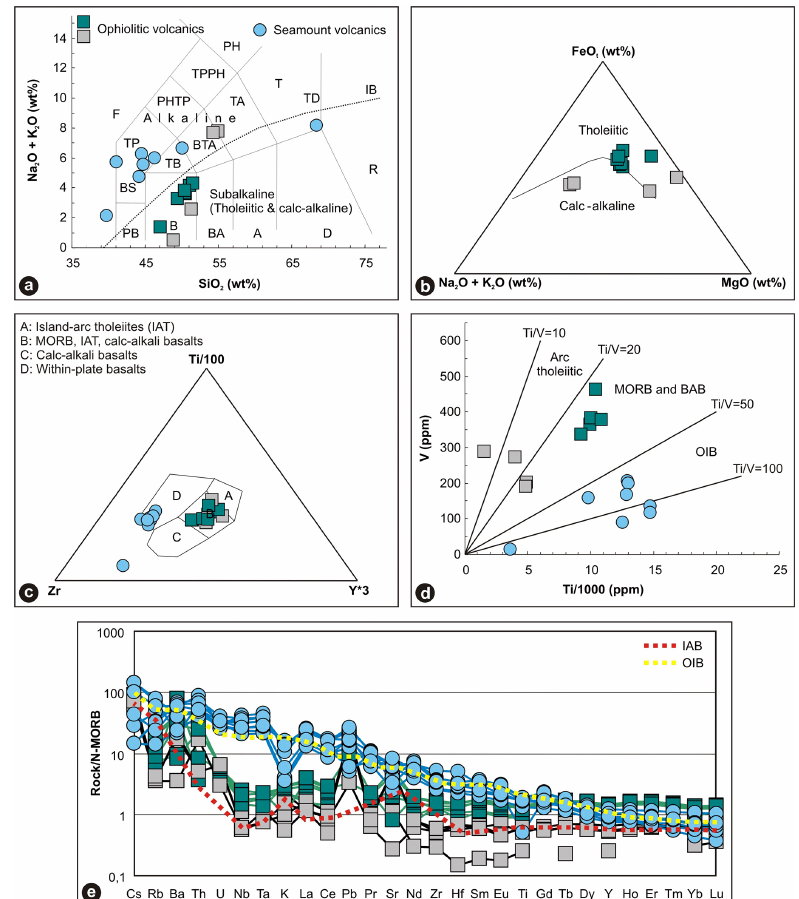
Fig. 13. Geochemical classification of ophiolitic and seamount volcanic rocks. (a) Total alkali vs. SiO 2 diagram (Le Bas et al., 1986). (b) AFM diagram (Irvine and Baragar, 1971). (c) Ti–Zr–Y discrimination diagram (Pearce and Cann, 1973). (d) Ti–V diagram (Shervais, 1982). (e) N-MORB normalized multielement diagrams of the most representative samples (normalization values from Sun and McDonough, 1989). Key to lettering: A = andesite, B = basalt, BA = basaltic andesite, BS = basanite, BTA = basaltic trachyandesite, D = dacite, F = foidite, PC = picrobasalt, PH = phonolite, PHTP = phonotephrite, TPPH = tephriphonolite, R = rhyolite, T = trachyte, TA = trachyandesite, TB = trachybasalt, TD = trachydacite, TP = tephrite. IB = alkali–subalkali subdivision from Irvine and Baragar